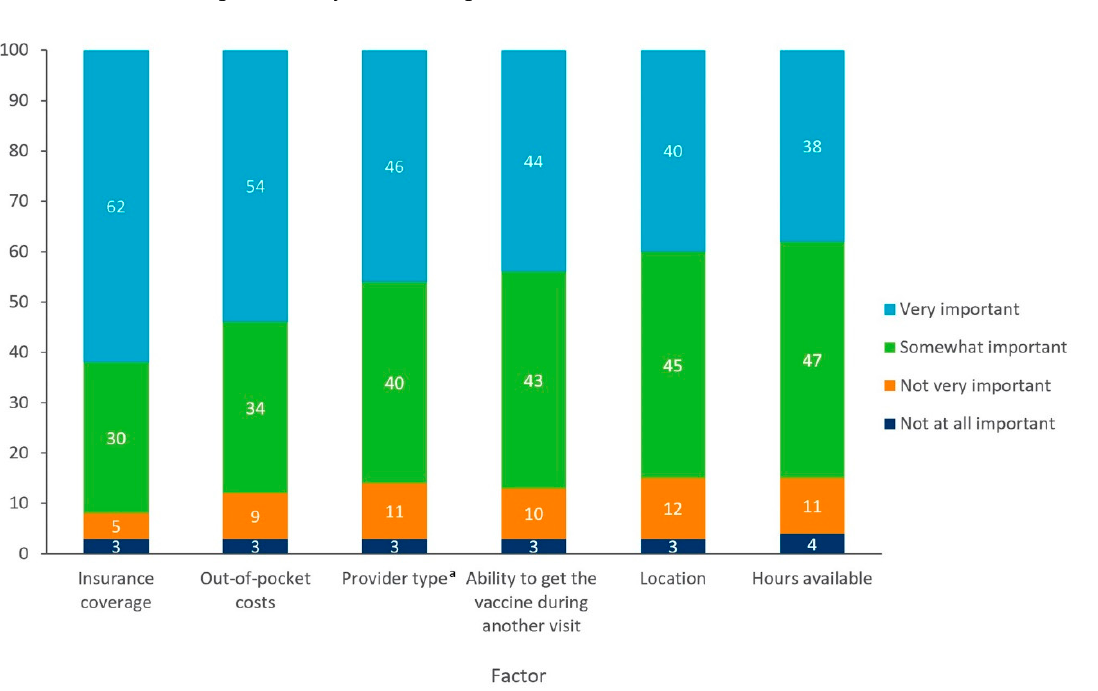
Figure 6. Level of trust in vaccine information sources for all respondents (n = 5000). a For example, the Centers for Disease Control and Prevention (CDC).